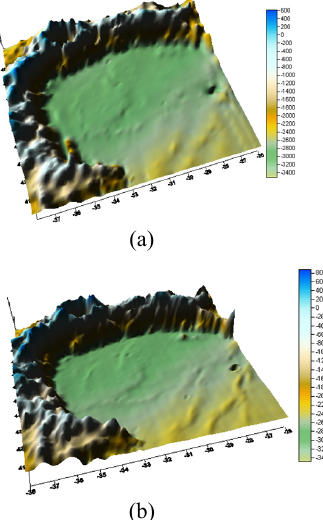
Figure 2. Interpolated DEM with the same resolution of 1200 m using Chang’E-1 (a) and SELENE (b) laser altimetry data at the Sinus Iridium area,